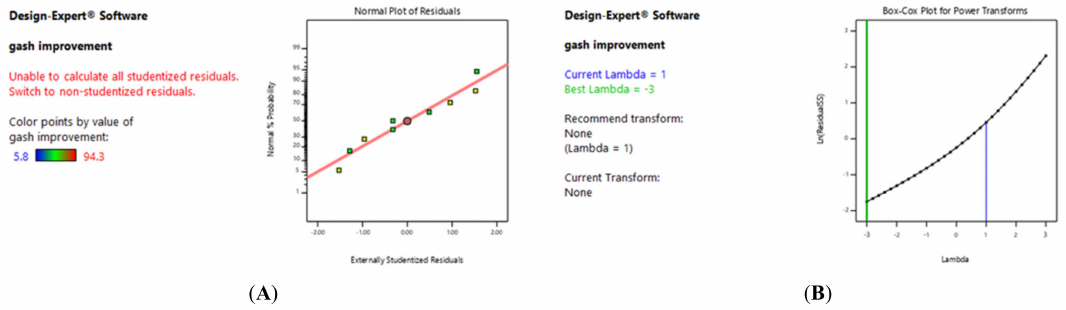
Figure 9. ( A ) Dispersion diagram of normal test distribution; ( B ) box Cox diagram of the healing